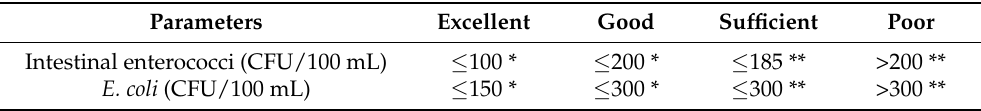
Table 5. Croatian standards for assessment of bathing water quality at the end of bathing season and for three preceding bathing seasons.